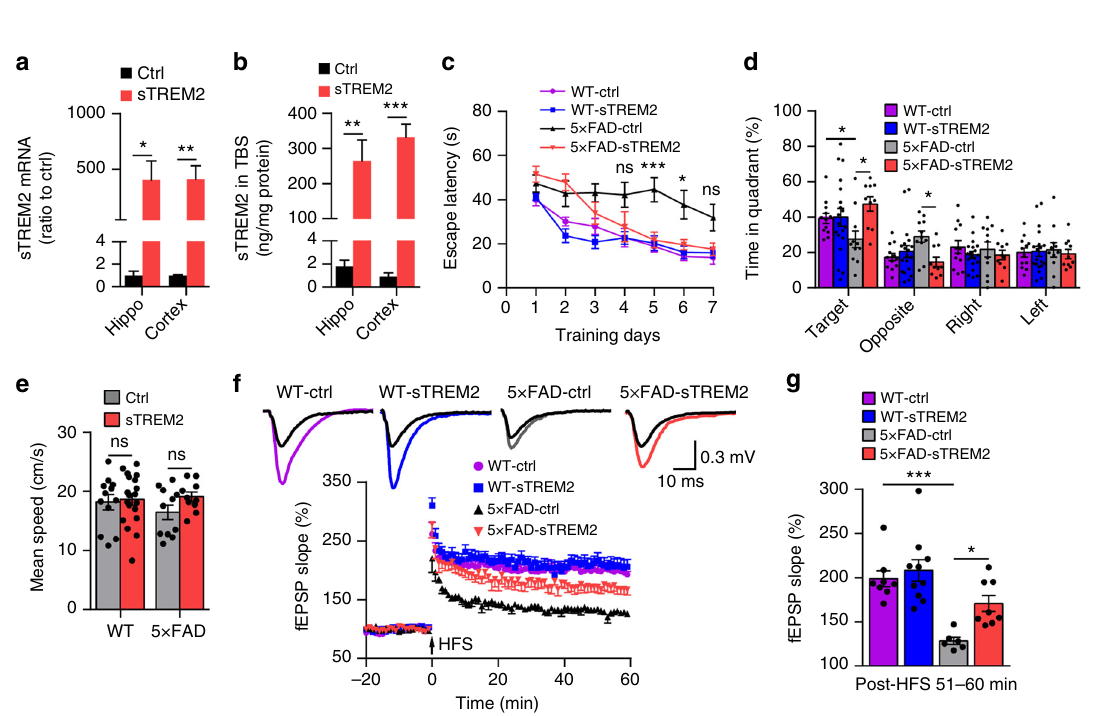
Fig. 7 AAV-mediated sTREM2 expression rescues behavioral and LTP de fi cits in 5×FAD mice. a , b Neonatal WT mice were injected with either control AAV or AAV-sTREM2 in the cerebral ventricles and analyzed after 7 months for sTREM2 expression at the mRNA ( a , n = 6 mice for Ctrl in hippo or cortex, n = 6 mice for sTREM2 in hippo and n = 5 mice for sTREM2 in the cortex, unpaired Student ’ s t test) or protein ( b , n = 6 mice per group, unpaired Student ’ s t test) levels in the cortex and hippcampus using RT-qPCR or ELISA, respectively. c – e Morris water maze tests were performed in wild-type (WT) or 5×FAD mice 6 months after injection of either control AAV or AAV-sTREM2 ( n = 12 mice for WT-Ctrl, n = 19 mice for WT-sTREM2, n = 11 mice for 5×FAD-Ctrl, and n = 10 mice for 5×FAD-sTREM2, two-way ANOVA, Bonferonni post hoc analyses). The escape latency time to reach the hidden platform was recorded during the 7-day training ( c ). Probe trial was performed 24 h after the last trial of a hidden platform task and the percentage of search time for each quadrant was recorded ( d ). Swimming speed of each group was recorded during the probe trial ( e ). f Time course of fEPSP measures recorded in the hippocampal CA1 region before and after 100-Hz stimulation in the Schaffer collateral region in slices from WT or 5×FAD mice 7 months after receiving control AAV or AAV-sTREM2. Normalized fEPSP slopes were plotted every 1 min for each group. g The averaged fEPSPs recorded 50 – 60 min after induction of LTP ( n = 8 slices for WT-Ctrl, n = 10 slices for WT-sTREM2, n = 6 slices for 5×FAD-Ctrl, and n = 8 slices for 5×FAD-sTREM2, at least three mice per group, two-way ANOVA, Bonferonni post hoc analyses). All data are presented as mean ± SEM. * p < 0.05; ** p < 0.01; *** p < 0.001; ns,